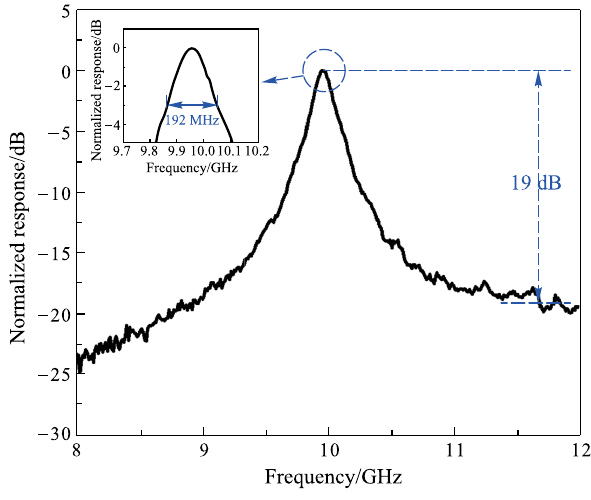
Fig. 5 Normalized response of the proposed single passband